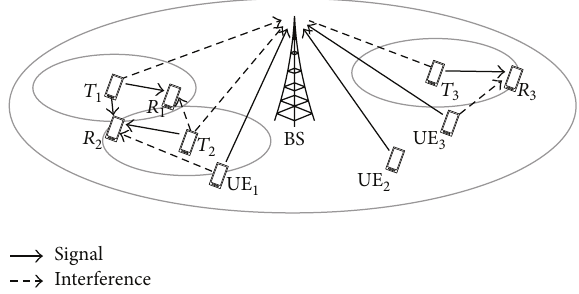
Figure 1: System model for D2D communications underlying cellular network when sharing uplink